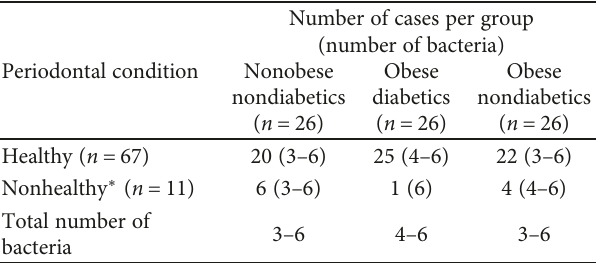
Table 4: Total number of bacteria in the saliva of obese patients (diabetics and nondiabetics) compared to the nonobese nondiabetic